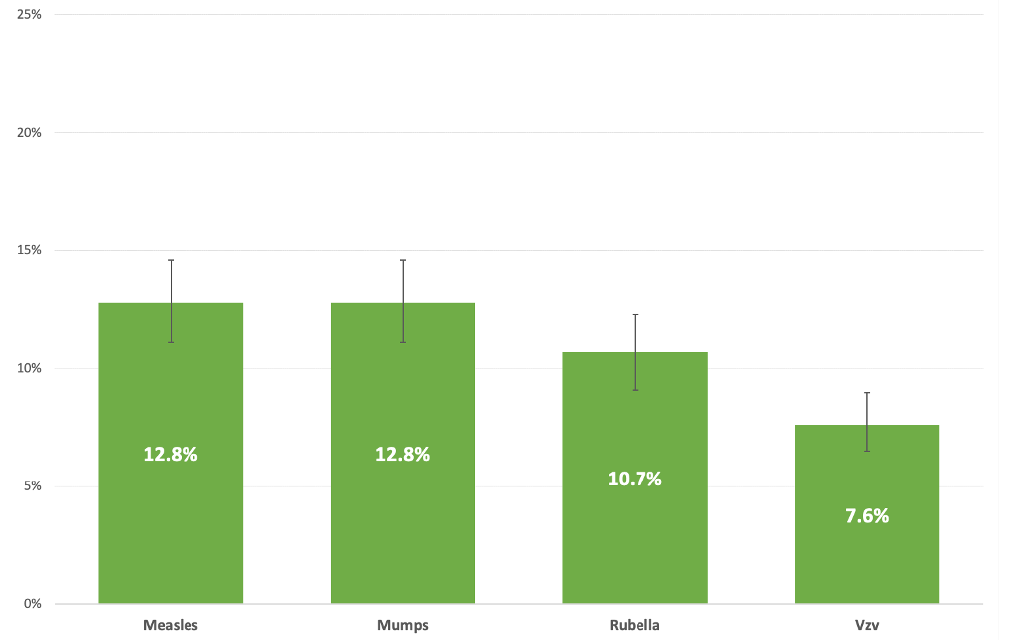
Figure 1. Results of multivariate analysis of determinants of serosusceptibility at enrollment are shown in Table 3.